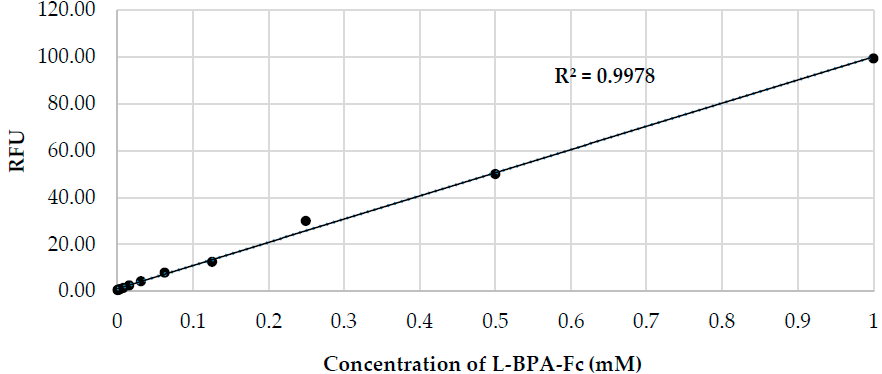
Figure 7. Effect of L-BPA-Fc concentration on the fluorescence intensity following staining with boron-sensor 5 (10 mM in 50 vol % DMSO/PBS, ex λ : 360 nm, em λ : 460 nm).